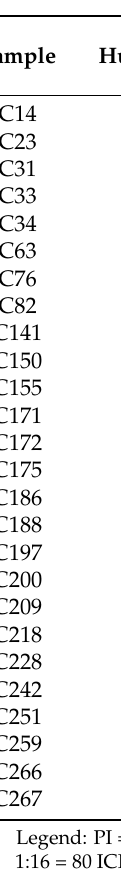
Table 2. Brucella spp. positive wild boar specimens in relation to hunting seasons, province, sex, age, serological, and molecular